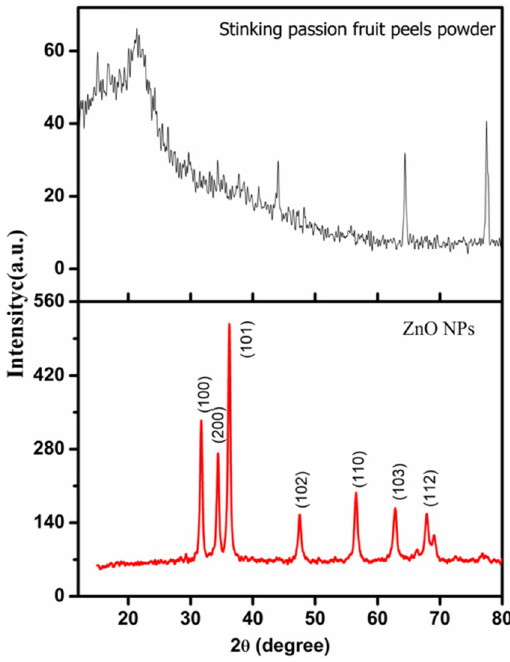
Fig. 5 XRD spectra of Stinking passion fruit peels powder and ZnO